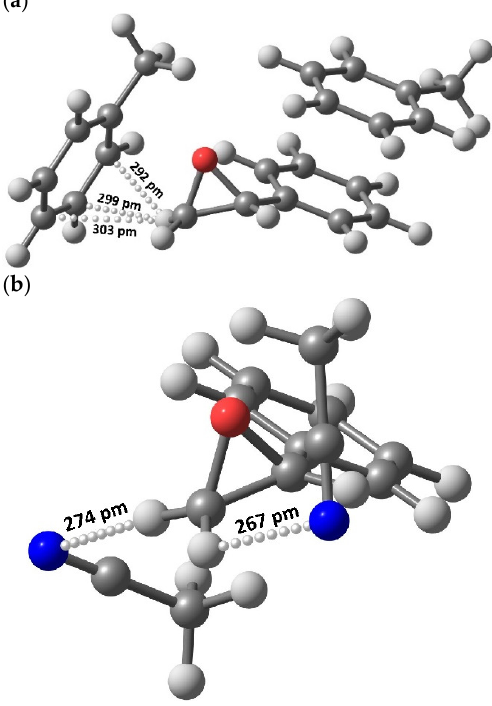
Figure 5. Optimized geometries using a DFT method showing H-bonding interactions between styrene oxide and toluene (C–H ··· π , ( a )) or acetonitrile (C–H ··· N, ( b